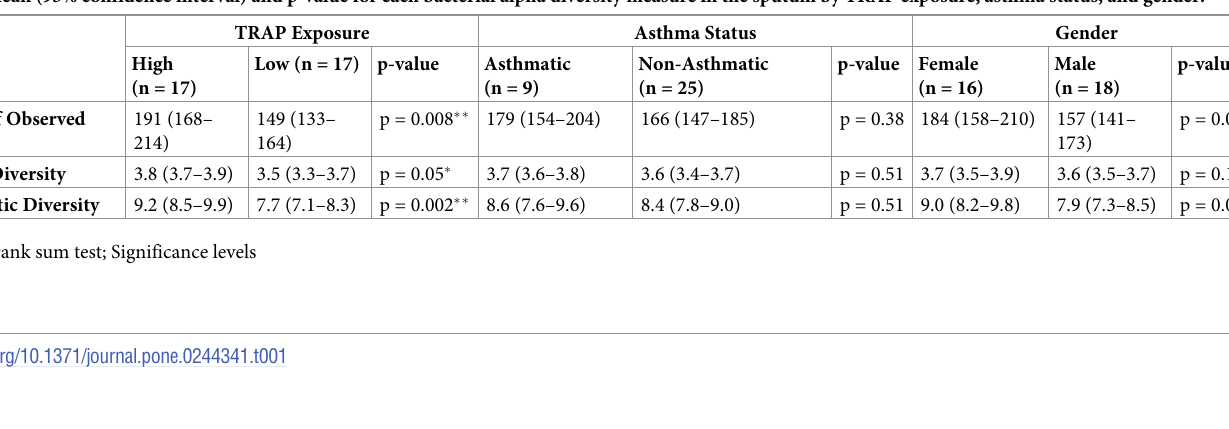
(Table 2). TRAP as a categorical variable was positively associated also with Shannon diversity. Female gender was positively associated with the number of observed ASVs and phylogenetic diversity, but not with Shannon diversity. Neither asthma status nor mother’s education were statistically significant predictors of alpha diversity indices.